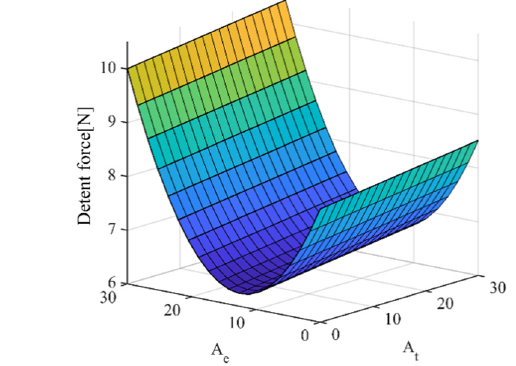
Figure 17. Response surface of A t (mm) vs. A e (mm), Detent force (N).